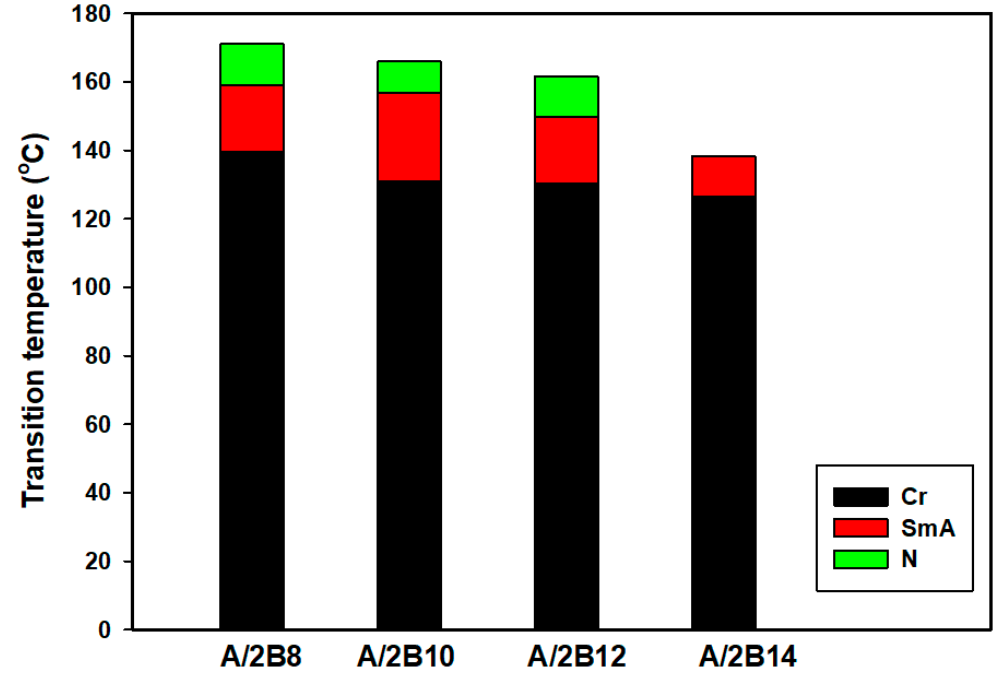
Figure 4. DSC graphical transitions of 1:2 SMHBLC complexes series, A/2Bn .